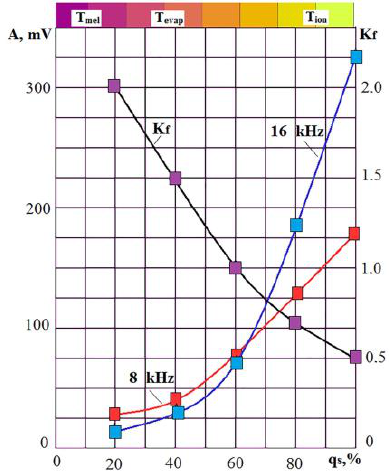
Figure 5. Change in the effective amplitude of the VA signal in the octave bands of 8 and 16 kHz and their K f ratio when the power density q s of laser pulses changes.